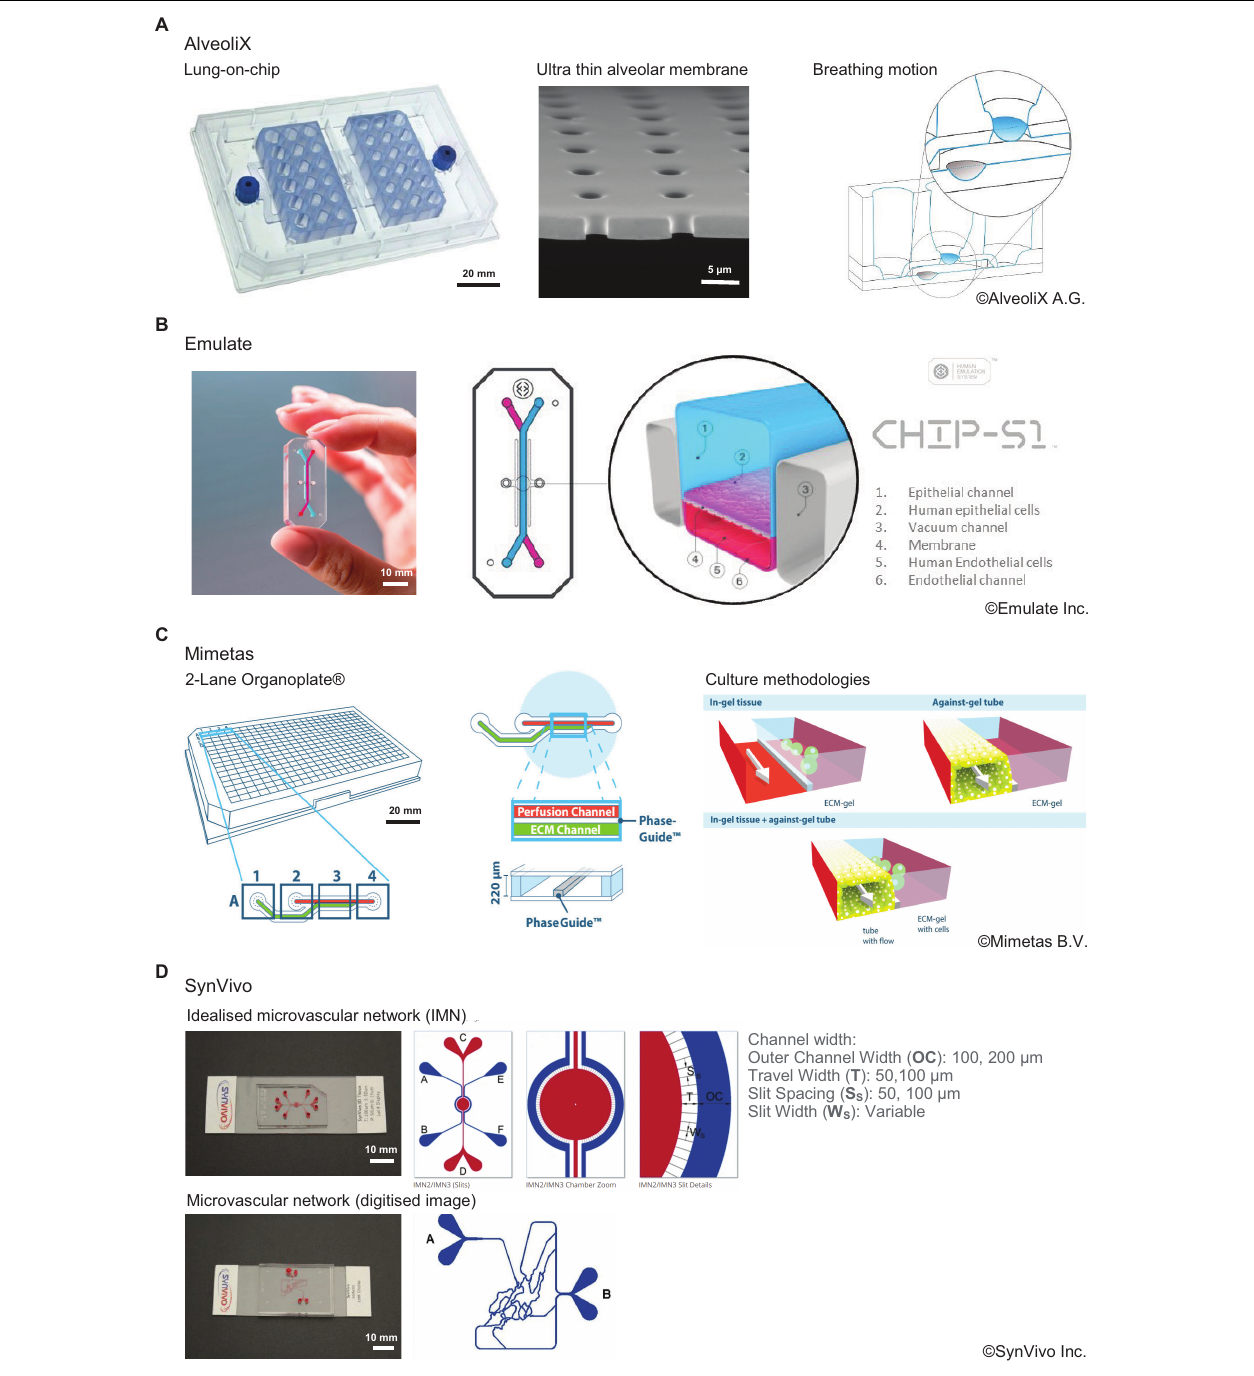
FIGURE 3 | Comparison of commercially available organ-on-chip platforms incorporating a form of active biophysical stimulus. (A) AX12 lung chip based on a 96-well plate format, consisting of two chips supported by a plate, each of which comprise six independent units. The ultrathin membrane (blue) is deflected by negative pressure inside the basal chip chamber through an integrated micro-diaphragm (gray). Images © Alveolix A.G. (B) The Human Emulation system from Emulate Inc. comprising organ chips which fit into the PodTM carrier. The ZoëTM culture module controls the rate of flow and stretch for up to 12 chips. The OrbTM provides the precise mixture of gas, power, and vacuum stretch required by the ZoëTM culture module. Images © Emulate Inc. (C) The 2-lane OrganoplateTM from Mimetas. Based on a 384-well plate format, it can support 96-individual models. Cells are cultured in/on ECM alongside a perfusion channel created using unique phase guide technology. Images © Mimetas B.V. (D) SynVivo’s microfluidic chips create an idealized microvascular network to mimic the formation of, and transport across, tight and gap junctions. Networks can also be created from digitized images to replicate in vivo physiology more accurately. Natural tissue regions can also be incorporated within the network topology. Images © SynVivo